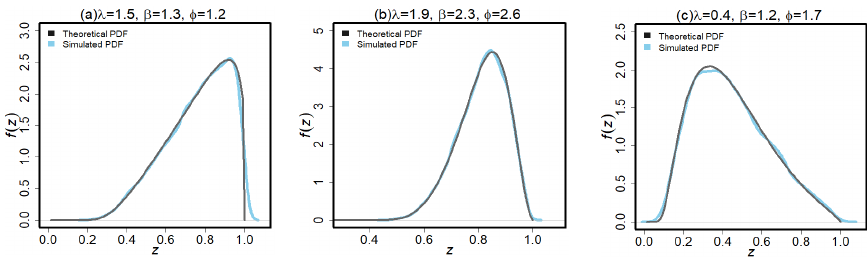
Fig. 8. Plot of theoretical and simulated PDF of HLUG-TI for certain parameters values. Figure 8. Plot of theoretical and simulated PDF of HLUG-TI for certain parameter